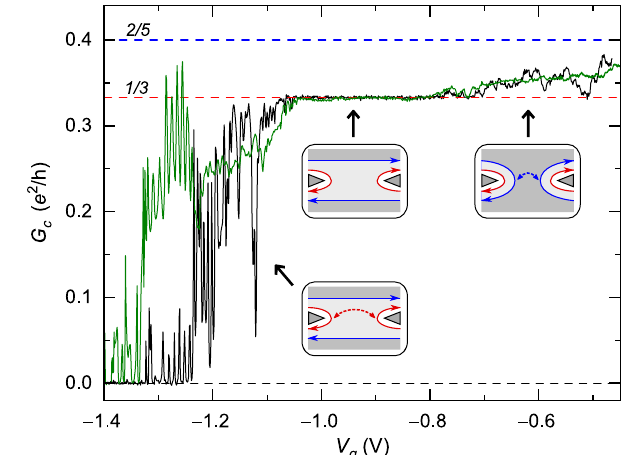
5. P versus source imbalance at ν ¼ 1 = 3 . Symbols display the effective Fano factor P as a function of the relative difference in incident currents I − =I , for the same device tuning. Horizontal þ over the range of applied error bars encompass variations in I − =I þ voltages.Vertical error bars representthedifference betweenvalues of P separately extracted at negative and positive voltages. The prediction of Eq. (8) is shown as a red continuous line. The alternative predictions shown as dashed lines involve the different definitions τ bis (black) and τ ter (blue)(see TableIIandAppendix c c